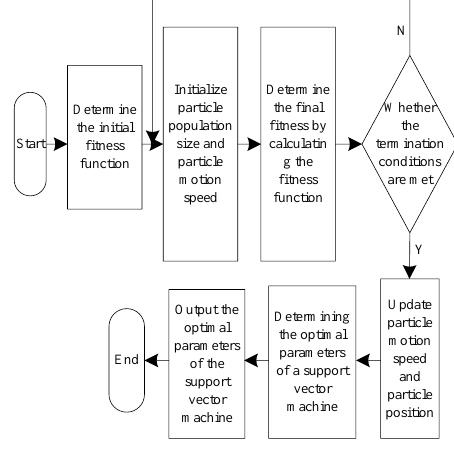
Figure 5. PSO optimizes support vector machine